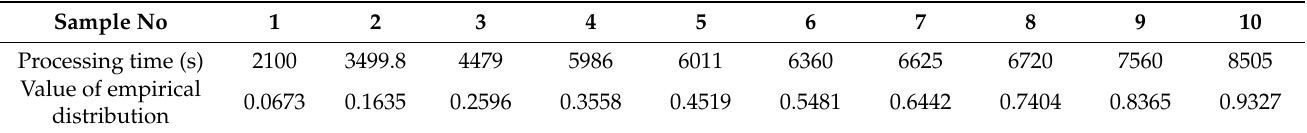
Table 4. First tool failure time and experience distribution.